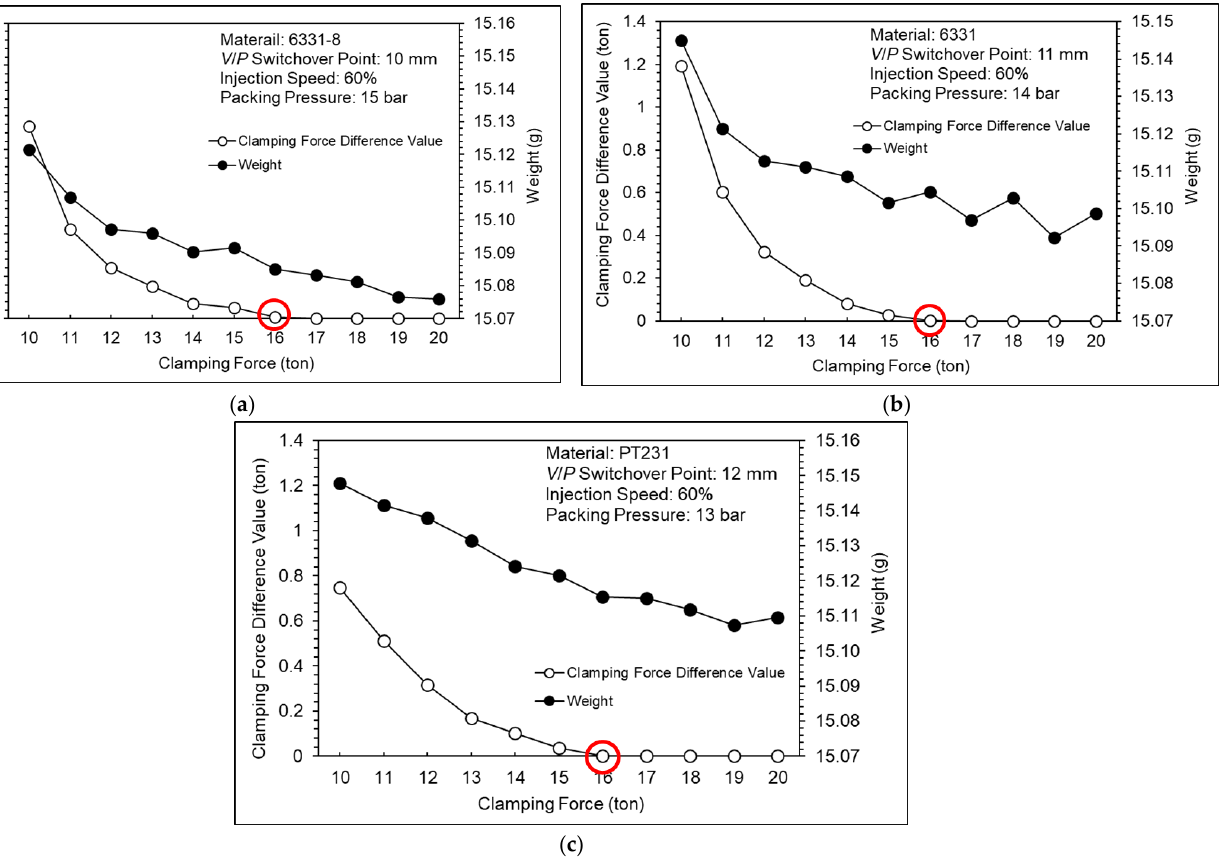
Figure 21. Clamping force difference value and product weight at different clamping forces (( a ) 6331 − 8, ( b ) 6331, and ( c ) PT231).